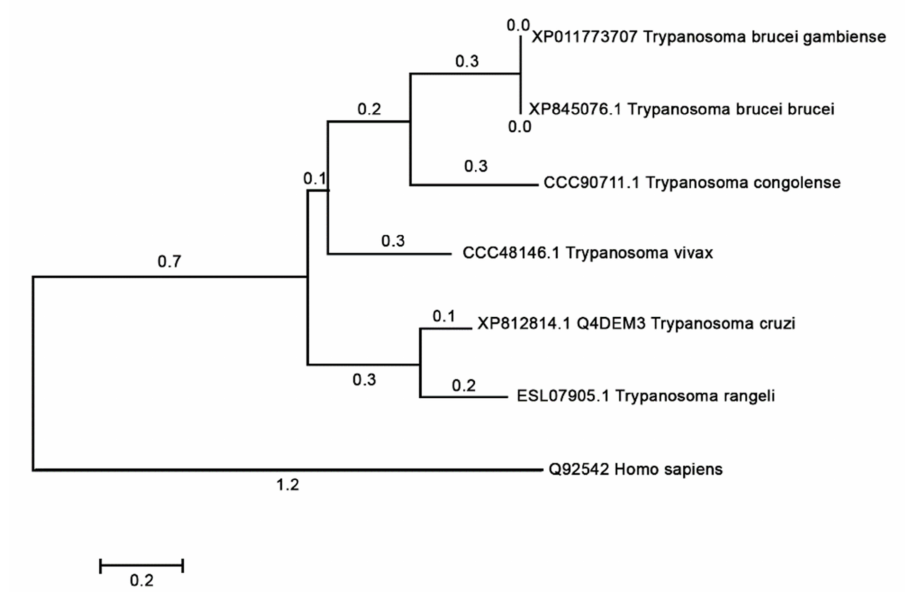
Figure 7. Phylogenetic relationship of T. cruzi nicastrin. The evolutionary history was inferred by using the Maximum Likelihood method based on the JTT matrix-based model [33]. The tree with the highest log likelihood is shown. Initial tree(s) for the heuristic search were obtained automatically by applying Neighbor-Join and BioNJ algorithms to a matrix of pairwise distances estimated using a JTT model, and then selecting the topology with superior log likelihood value. Evolutionary analyses were conducted in MEGA7